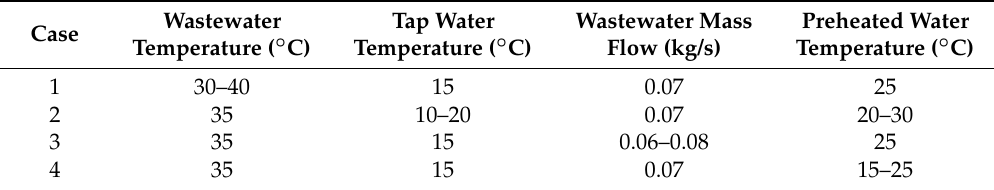
Table 1. Different working conditions of the steady simulation.